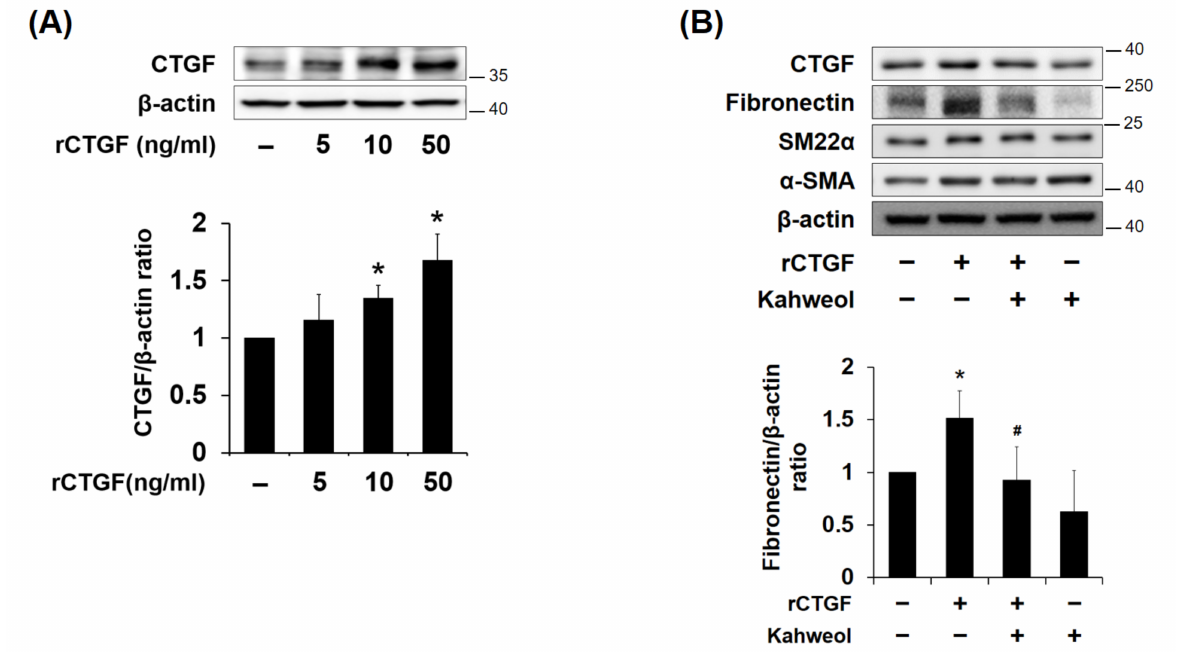
Figure 4. Effect of kahweol on CTGF induced phenotype switching in VSMCs. ( A ) Cells were stimulated with rCTGF (50 ng/mL) for 24 h at the indicated dosages and then ( B ) Cells were pretreated with rCTGF (50 ng/mL) for one hour and then treated with kahweol (10 µ M) for 24 h. Protein levels of CTGF, fibronectin, SM22 α , α -SMA, and β -actin were determined by Western blotting with specific antibodies. Bar graphs present the densitometric quantification of the Western blot bands. Results are representative of three independent experiments. *, p < 0.05; vs. untreated control; #, p < 0.05; vs. rCTGF